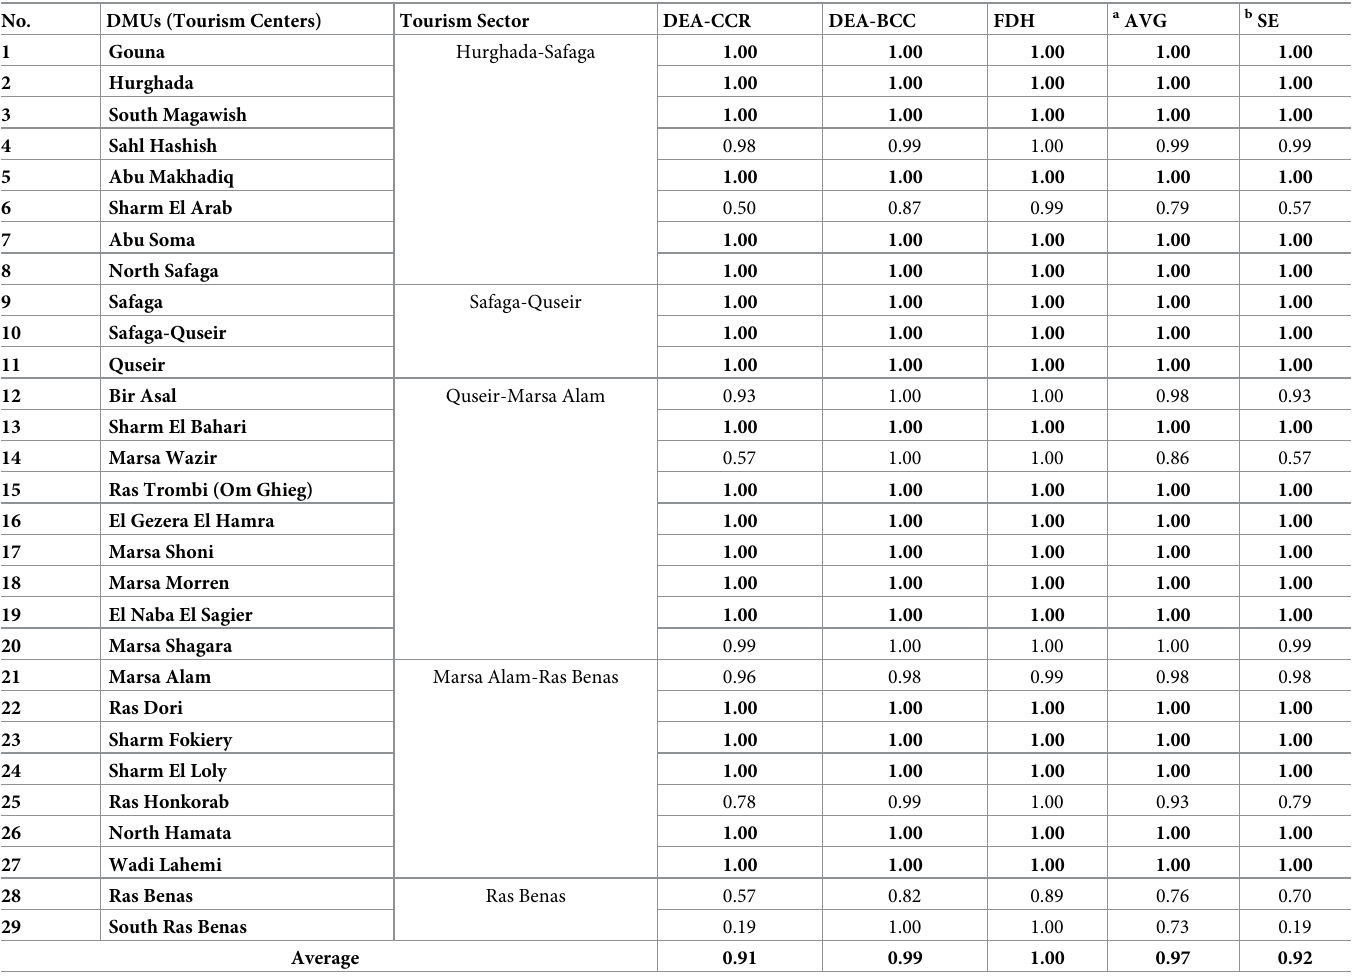
Table 2. DEA for measuring the efficiency of the coastal tourism centres in the Southern Red Sea region, Egypt. No.